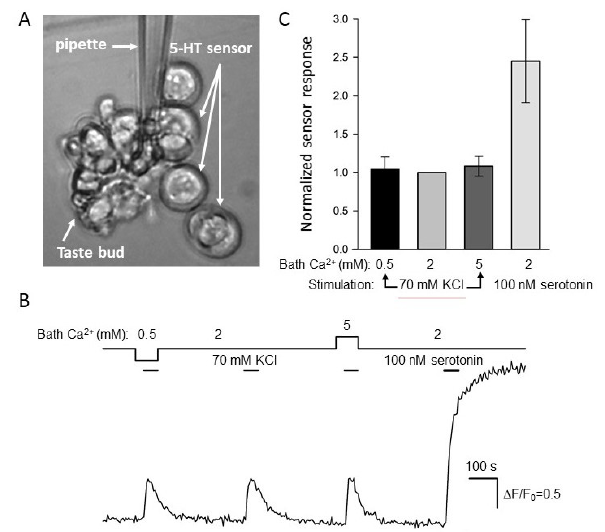
Figure 4. Biosensor assay of serotonin release. ( A ) Taste bud positioned nearby 5-HT 4 /PF-positive HEK-293 cells. ( B ) Evolution of the cAMP signal in the serotonin biosensor (the second 5-HT 4 /PF-cell from above) during the release assay in ( A ). The depolarization of taste bud cells by 70 mM KCl stimulated serotonin release that was apparently unaffected by a change in bath Ca 2+ (solid line above the cAMP trace). The control application of exogeneous serotonin (100 nM) elicited a much higher response, indicating that the biosensor was not saturated by released serotonin. The deviations of cytosolic cAMP were quantified by the ratio ∆ F/F 0 , where ∆ F = F − F 0 , F is the instant fluorescence of the cAMP sensor Pink Flamindo, F 0 is the averaged fluorescence at the very beginning of the recording. ( C ) Averaged cAMP responses of the 5-HT 4 /PF sensor upon taste bud depolarization as in ( B ) at bath Ca 2+ of 0.5, 2, and 5 mM as well as by the stimulation with 100 nM serotonin. The data are presented as the mean ± S.D. ( n = 22).